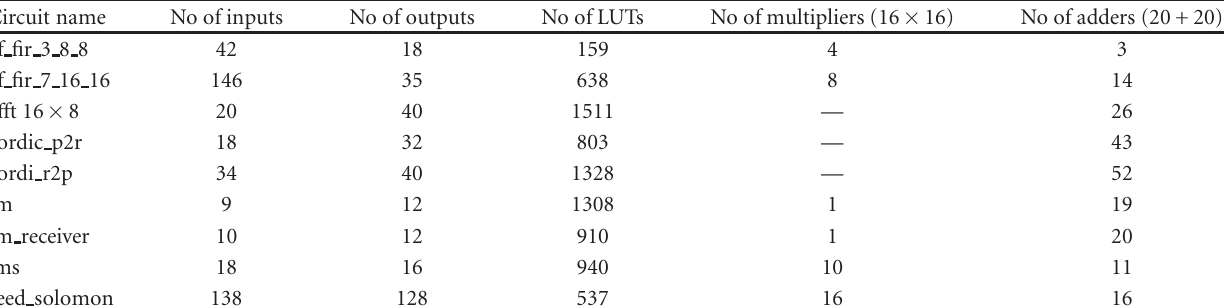
Table 2: Open core benchmarks set II.